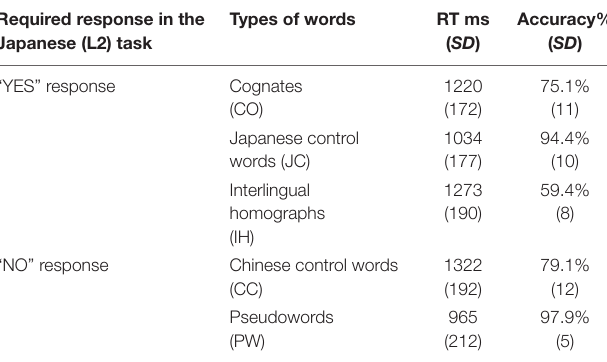
TABLE 1 | Mean reaction times (RT) and accuracy rates associated with each word